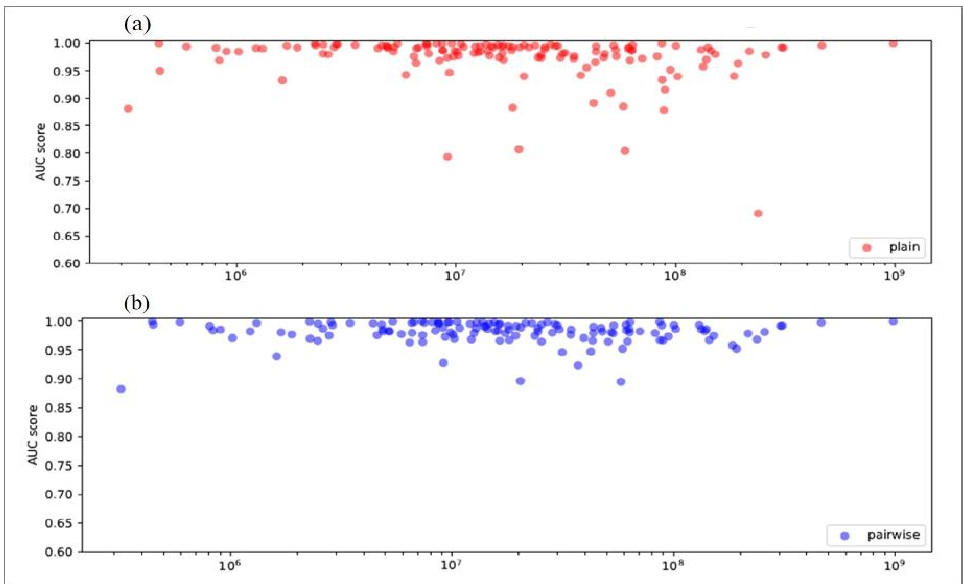
Figure 9. Network AUC score and network traffic size on all input data (HTTP and HTTP(S)): ( a )